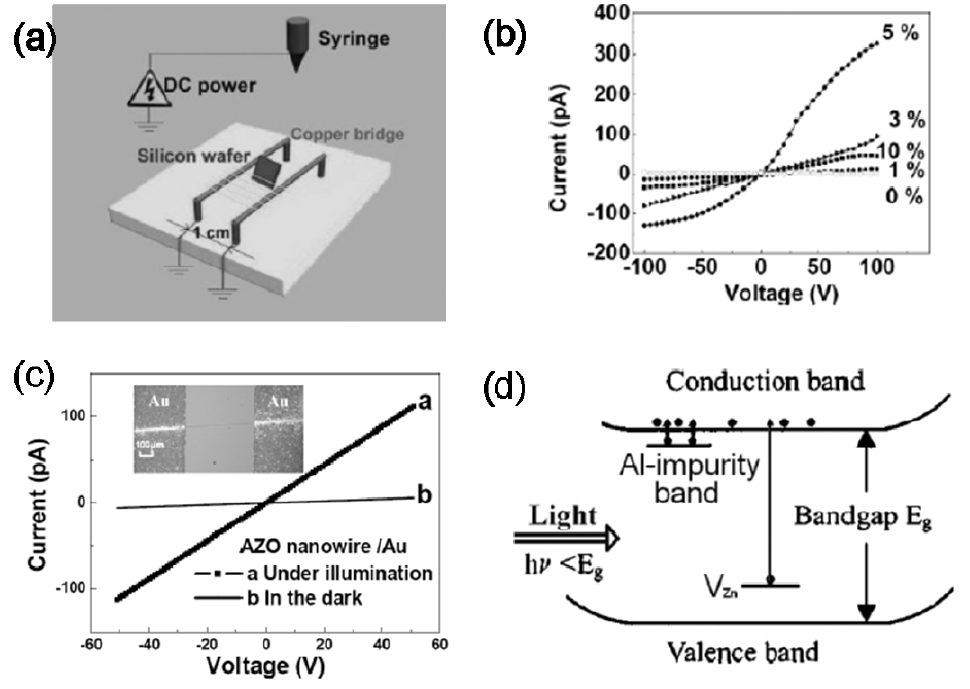
Figure 3. (a) Schematic illustration of the setup used for electrospinning nanowires as uniaxially aligned arrays; (b) The measured current-voltage (I-V) curves of undoped and Al-doped samples; (c) Photoresponse of the Al-doped ZnO nanowires (1 at% Al) to below-gap illumination (Au electrodes); (d) Schematic energy band diagram of the photoswitches. Reproduced from